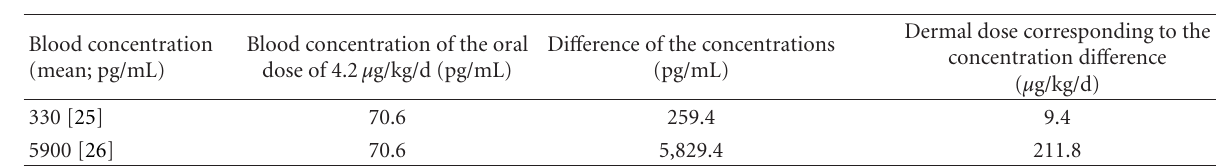
4433 Dermal dose corresponding to